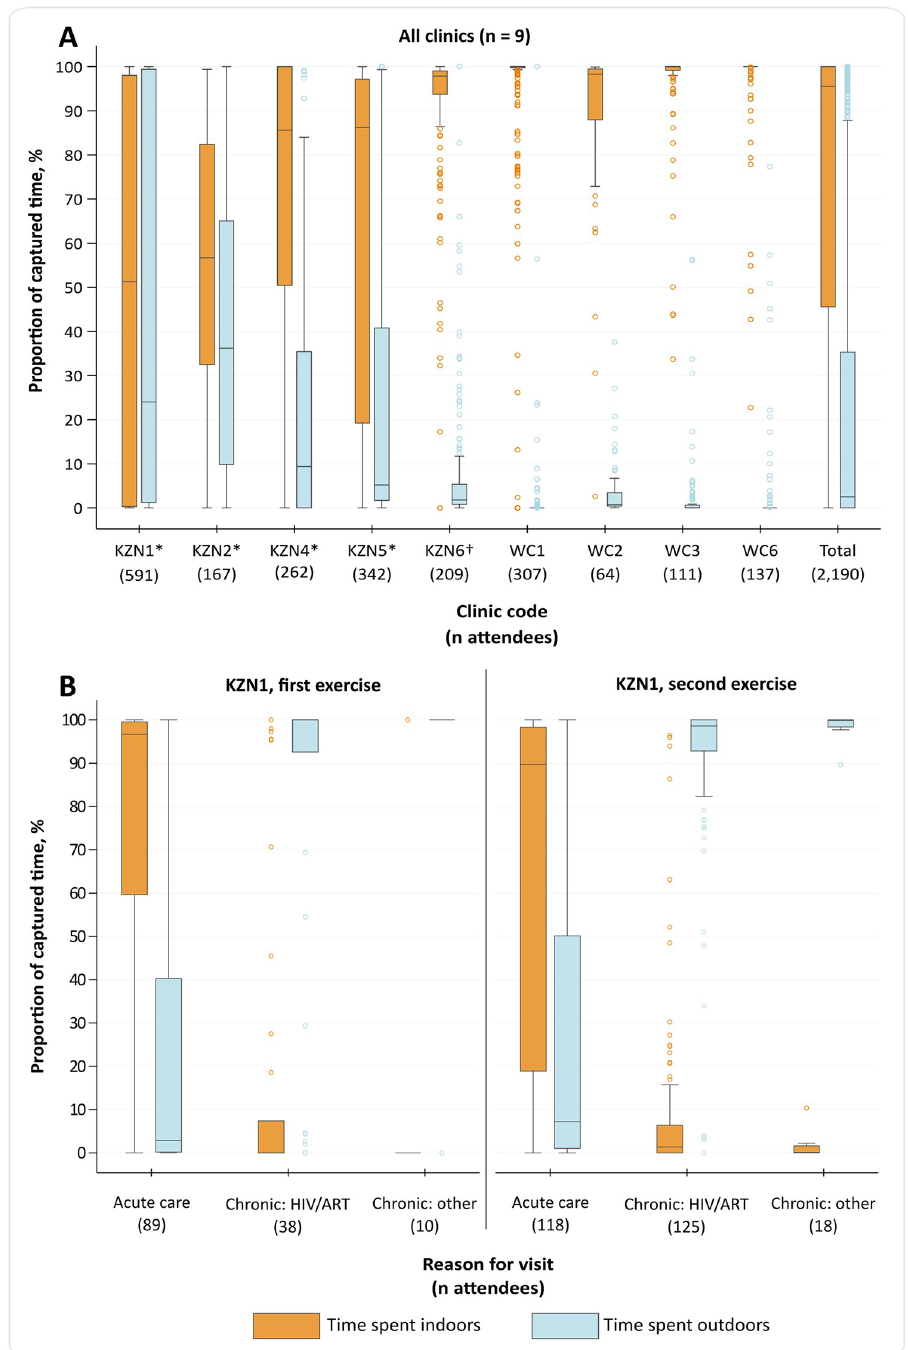
Fig 1. Box and whiskers plots showing proportions of time spent indoors and outdoors, by clinic (panel A) and for two visits to clinic KZN1, by selected reasons for visit (panel B). � Clinic has at least one outdoor waiting area that is part of a designated patient pathway. †Clinic has at least one outdoor waiting area, but it is not part of a designated patient pathway. The central horizontal line represents the median value; boxes represent the interquartile range (IQR); and whiskers represent largest and smallest values within 1.5 IQR of the upper and lower quartiles, respectively. Time spent in unknown locations was negligible for most clinics and is therefore not shown. Panel A: Proportions are shown by clinic for all attendees at nine clinics with at least five minutes captured. Data from both data collection exercises at clinic KZN1 are shown combined. Panel B: Proportions are shown by self-reported reason for attendance for individuals with at least five minutes captured who were attending clinic KZN1 for the three selected reasons. ART: antiretroviral therapy; KZN: KwaZulu-Natal; TB: tuberculosis; WC: Western Cape. https://doi.org/10.1371/journal.pgph.0000684.g001 PLOS Global PublicHealth | https://doi.org/10.1371/journal.pgph.0000684 July 20,